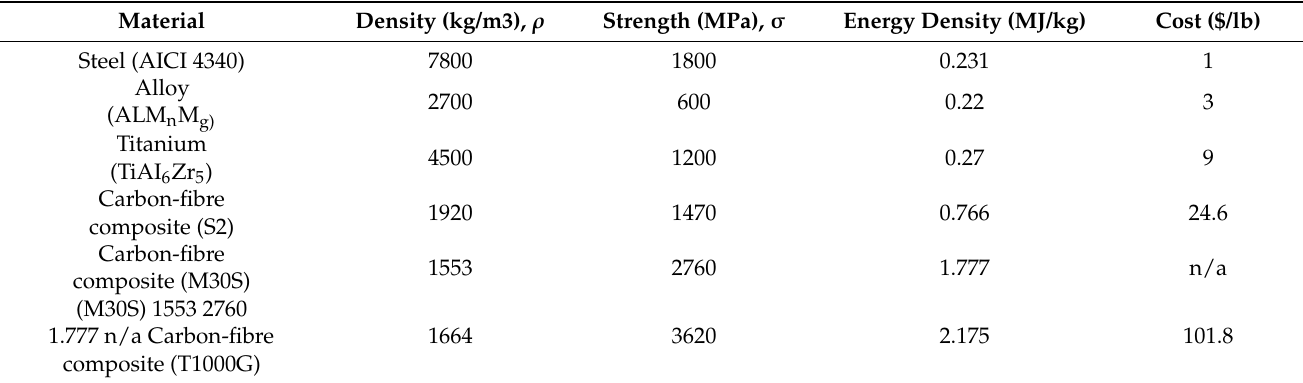
Table 5. Materials for rotor of FESS